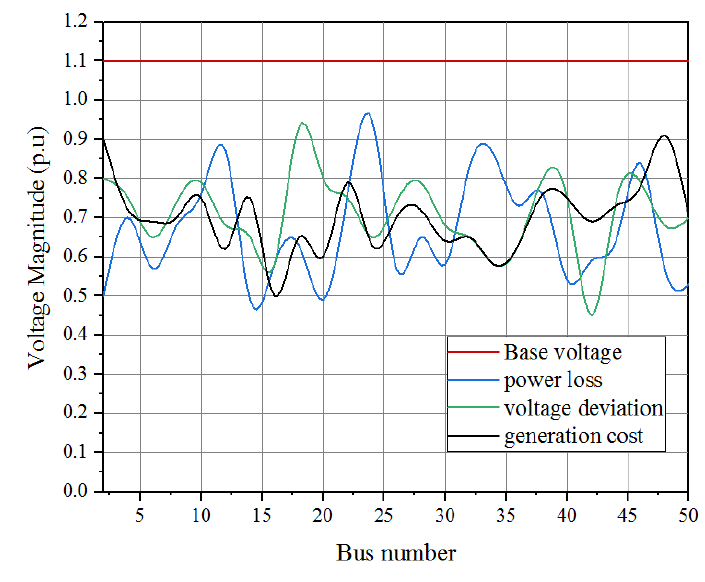
Figure 6. Voltage profiles of IEEE 50-bus system.